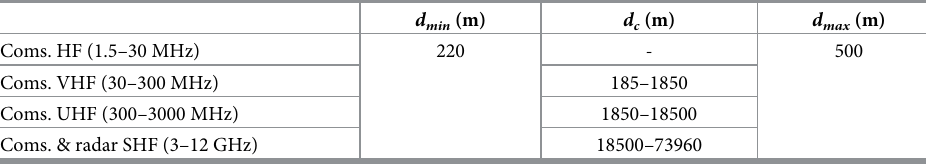
Table 3. Minimum flight distance according to criteria (reduced